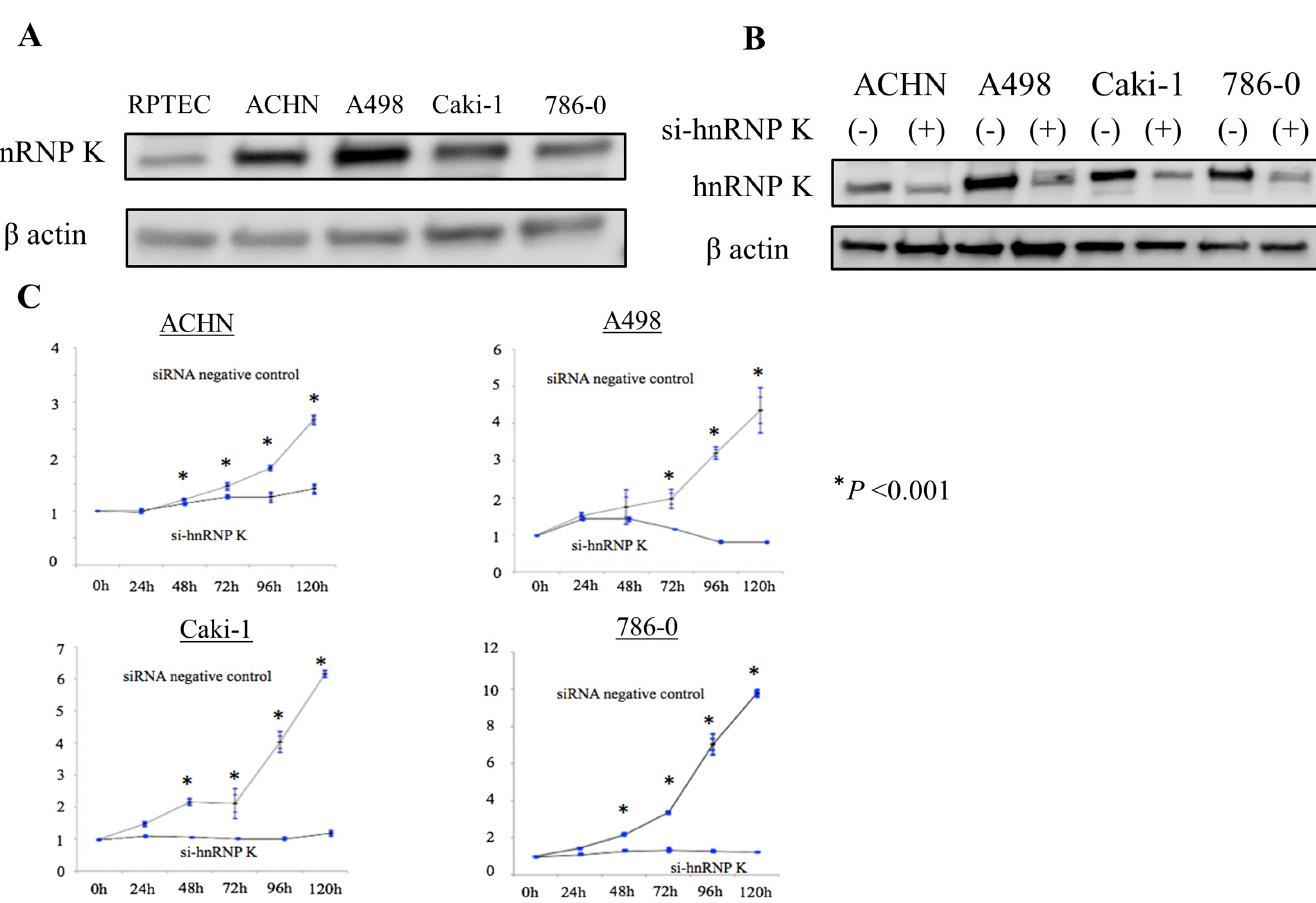
Fig 1. Inhibition of proliferation in RCC cells by hnRNP K knocking down. Expression of heterogeneous nuclear ribonucleoprotein (hnRNP) K in both normal renal proximal tubule cell line (RPTEC) and renal cell carcinoma (RCC) cell lines, and growth inhibition of four RCC cell lines after knock-down of endogenous hnRNP K. As described in the Materials and Methods section, the number of viable RCC cells after treatment with control siRNA or siRNA against hnRNP K (si-hnRNP K) for 0, 24, 48, 72, 96 or 120 h was determined by water-soluble tetrazolium salt (WST-1) assay. A. Total cell lysates were prepared from each cell line and analyzed by western blotting using anti-hnRNP K antibody to detect hnRNP K protein (upper panel). To elucidate equal loaded amounts of total cell lysates, western blotting using anti- β -actin antibody was also performed (lower panel); B. Each RCC cell line transfected with negative control siRNA or si-hnRNP K was harvested 72 h after transfection and total cell lysates were analyzed by western blotting using anti-hnRNP K antibody to evaluate the efficacy of si-hnRNP K; C. Values measured at 0 h with control siRNA or si-hnRNP K were determined as 1. Three individual experiments were performed. Results were presented as mean ± S.D. * P < 0.05 compared with control (Student ’ s t -test, n =